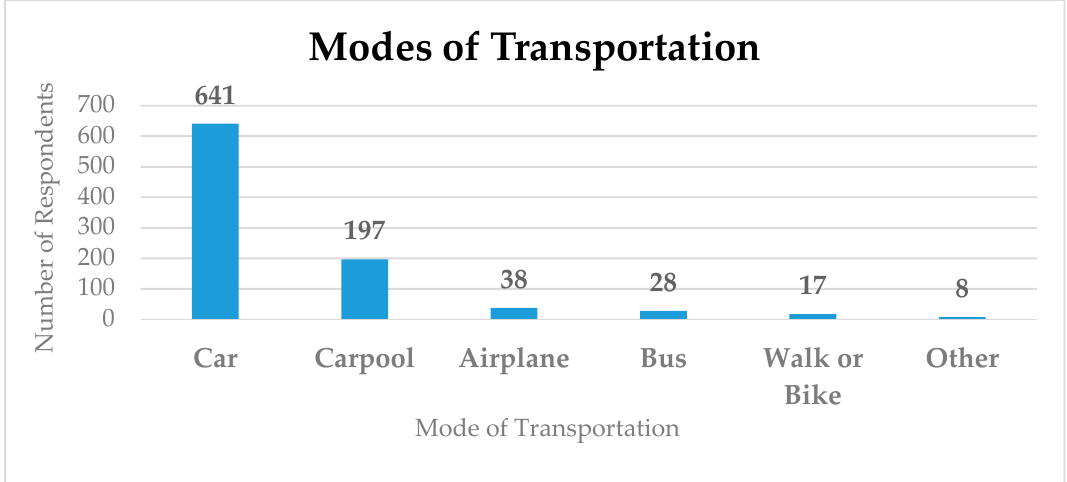
Figure 2. Mode of transportation groups for the N = 929 active sport event participants. The columns